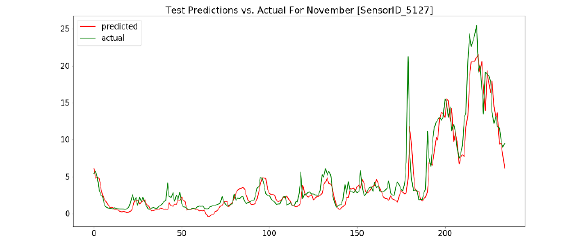
Figure 11. Effect of Distance from Base sensor on R 2